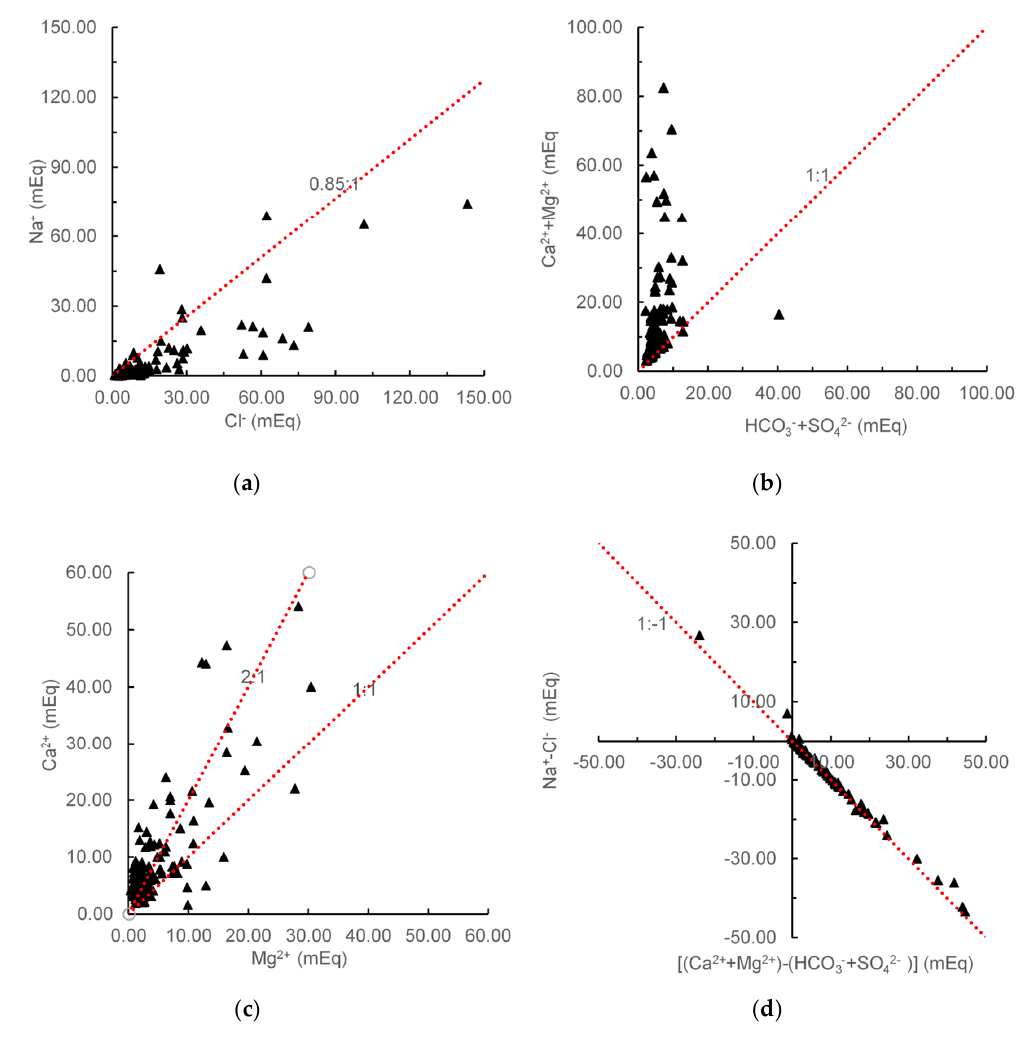
Figure 14. Ion ratios of groundwater samples. ( a ) γNa + /Cl − , ( b ) γ(Ca 2+ +Mg 2+ )/γ(HCO −